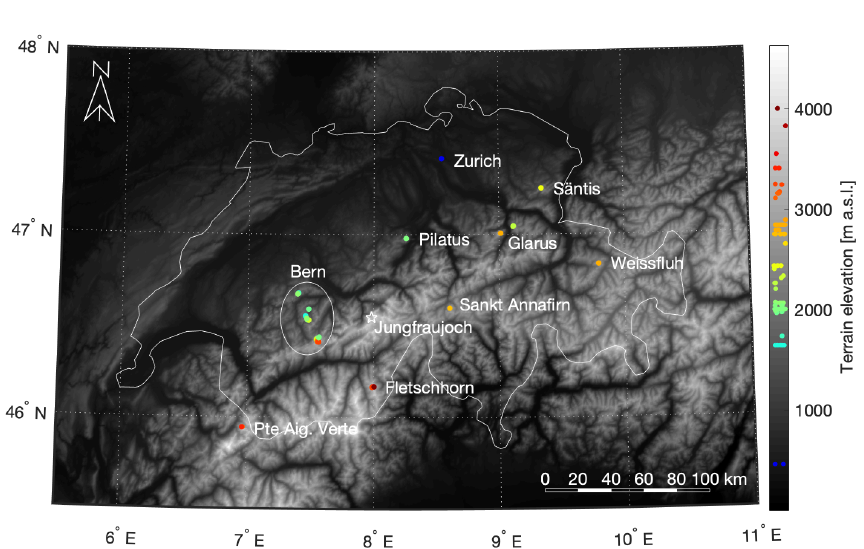
Figure 1. Map of all sampling sites (colored dots) within the Swiss border (white outline). The circled sites are within the canton of Bern and include Schibe, Rauflihore, Meniggrat, Alpetli, Chalberhöri, Engstligenalp and Grossstrubel. The high-altitude alpine research station Jungfraujoch is identified with a star for reference, although no snowmelt was collected at that site. The respective altitudes of the sampling sites are shown on the color bar to the right, scattered in the x direction to avoid overlapping of points. The terrain elevation is greyscale shaded according to a digital elevation model produced using Copernicus data and information funded by the European Union – EU-DEM layers (European Environment Agency, 2018). See Fig. S5 for selected images of the